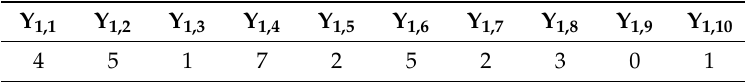
Table 2. Available capacity for UDC 1 , UDC: urban distribution center.